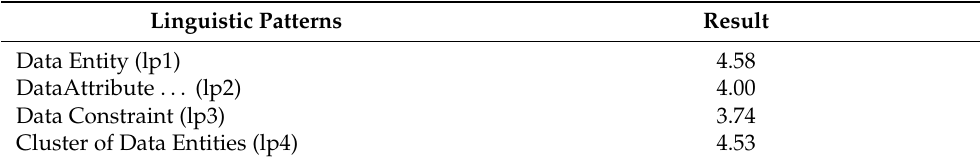
Table 4. How do participants rate the proposed linguistic patterns (values in a 1–5 scale)? Linguistic Patterns Result Data Entity (lp1) DataAttribute . . .